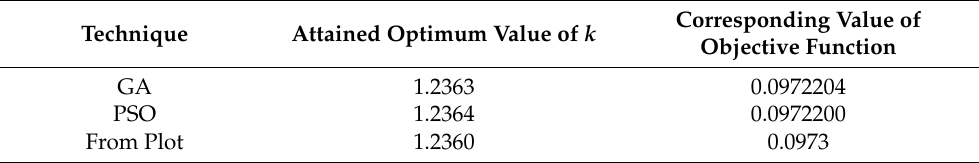
Table 8. Comparison of results among different per-phase equivalent circuit